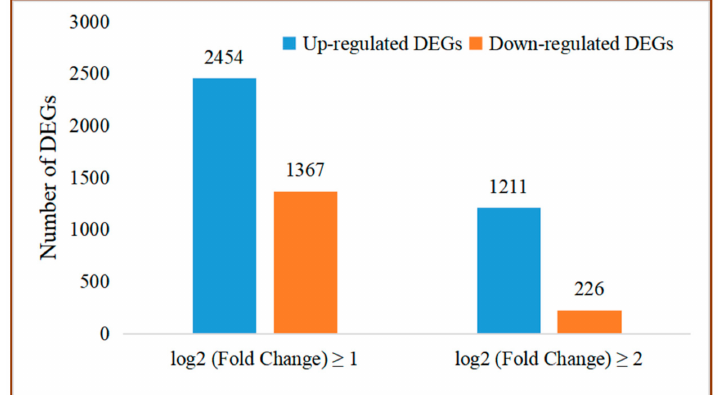
Figure 2. Number of DEGs between treated and control samples.